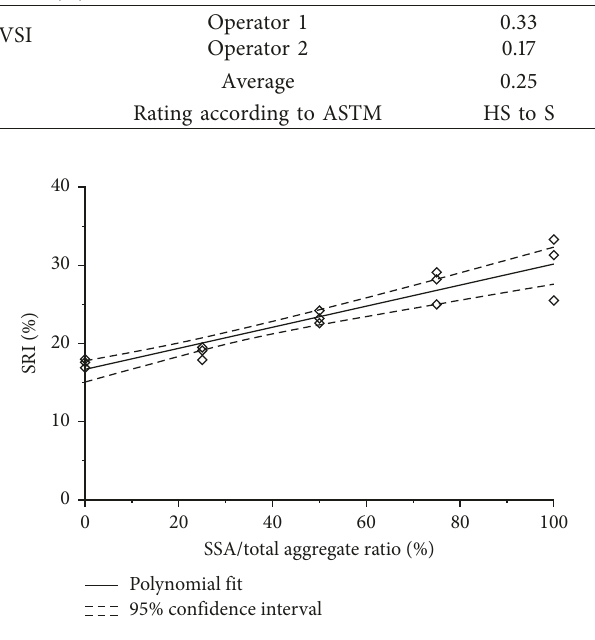
Figure 4: Relationship between the SSA replacement ratio and the SRI.